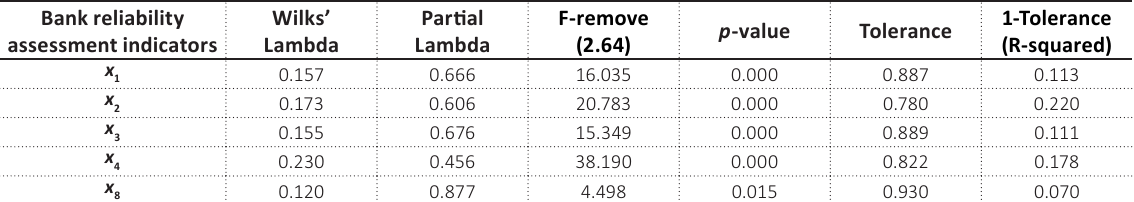
Source: Own processing.